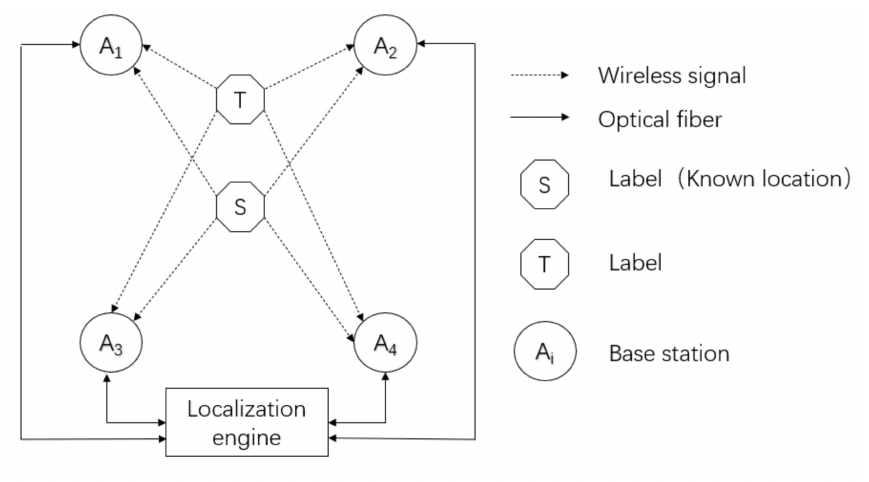
Figure 3. Schematic diagram of error